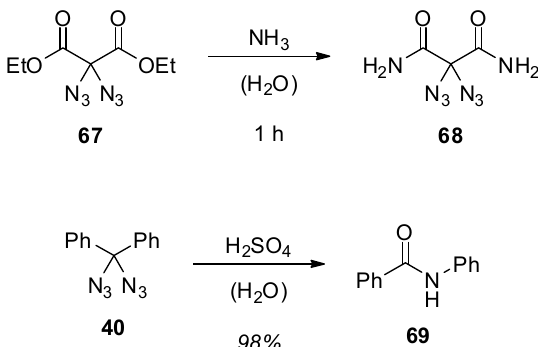
Scheme 13. Simple intermolecular reactions of geminal diazides.